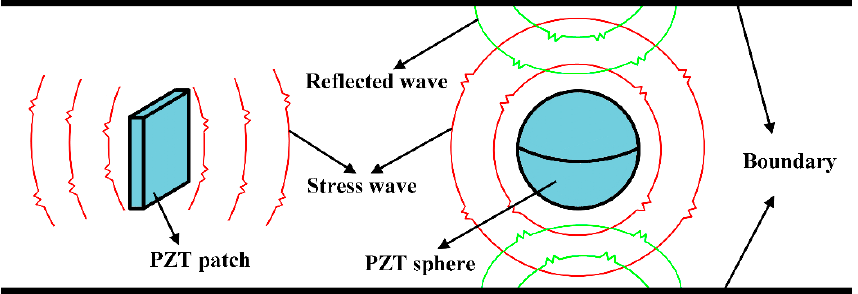
Figure 1. Stress waves generated by a lead zirconate titanate (PZT) patch vs. a PZT sphere in a two-dimensional concrete structure.